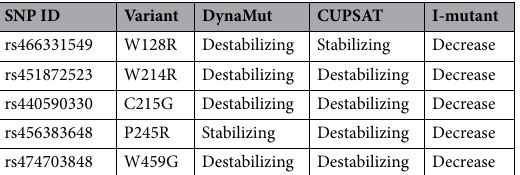
Table 2. List of selected significant deleterious nsSNPs and their effects on DGAT1 structure predicted by structure-based tools.